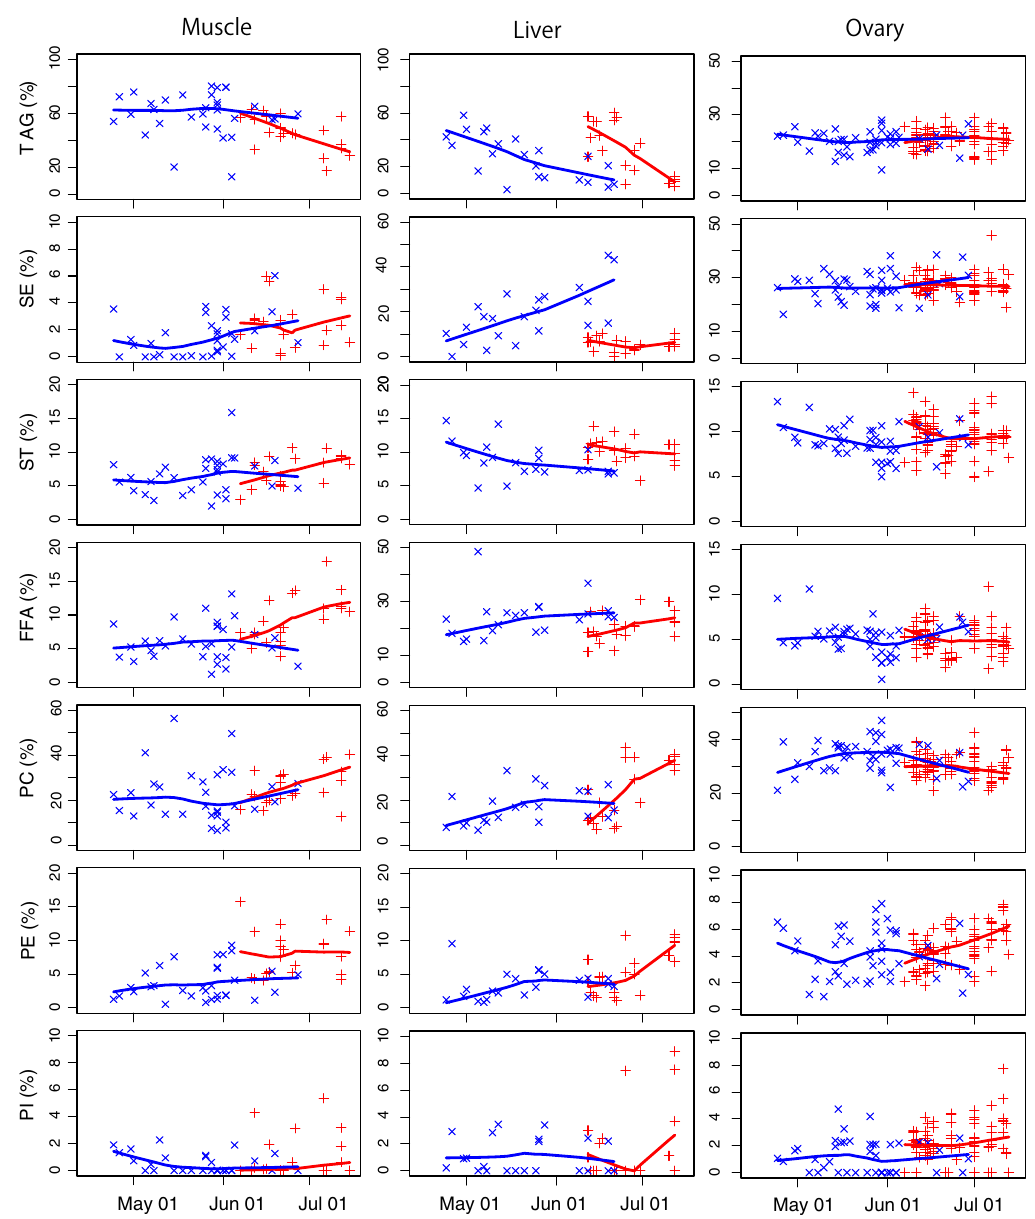
Fig 4. Temporal variation in lipid classes in muscle (left), liver (middle) tissues, and oocytes (stage Ly) from within the ovary (right) of female Pacific bluefin tuna from the Nansei Islands ( × ) and Sea of Japan (+); with Lowess smoothing curves (bandwidth, 0.8). TAG, triacylglycerols; SE, sterol esters; ST, sterols; FFA, free fatty acids; PC, phosphatidylcholine; PE, phosphatidylethanolamine; PI, phosphatidylinositol.